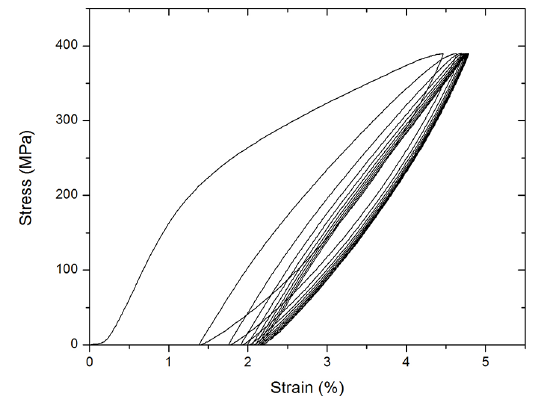
Figure 7. Test for the quantification of the superelasticity at the temperature of 25 ºC with 10 cycles of deformation for Cu-11.8Al- 0.6Be-4Nb (wt.%)